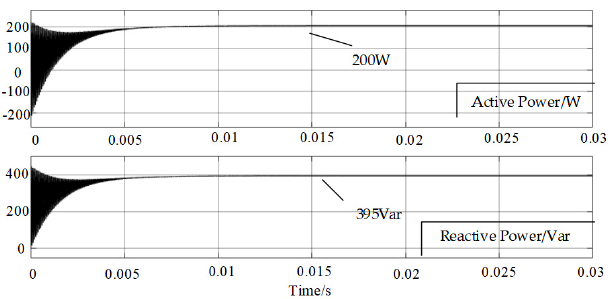
Figure 23. φ AD = 25.8° and φ AB = 152° bridge-arm C drain-source voltage and current waveforms. When full-arm ZVS is achieved, the A-arm current changes from negative to positive after the A-arm drain-source voltage drops to 0. The B-arm current changes from positive to negative after the B-arm drain-source voltage drops to 0. The C-arm current changes from negative to positive after the C-arm drain-source voltage drops to 0. A combination of phase-shift angles within the ZVS range of the two full-bridge arms was randomly selected for the same power and gain, and the phase-shift angles ( φ AD = 97.2°, φ AB = 115°) were chosen for the comparison of reactive power values, as shown in Figure 24.